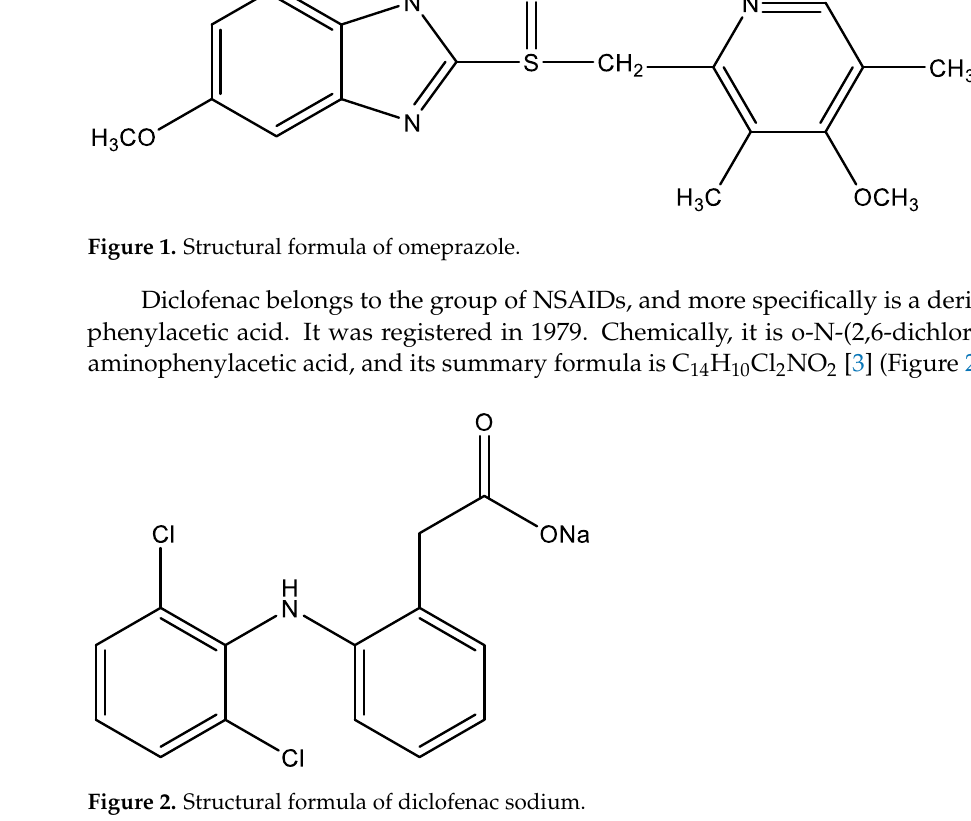
Figure 1. Structural formula of omeprazole.